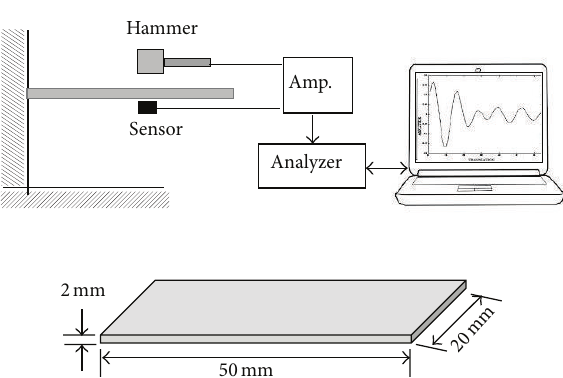
Figure 3: Schematic diagrams of experimental setup for the damp- ing